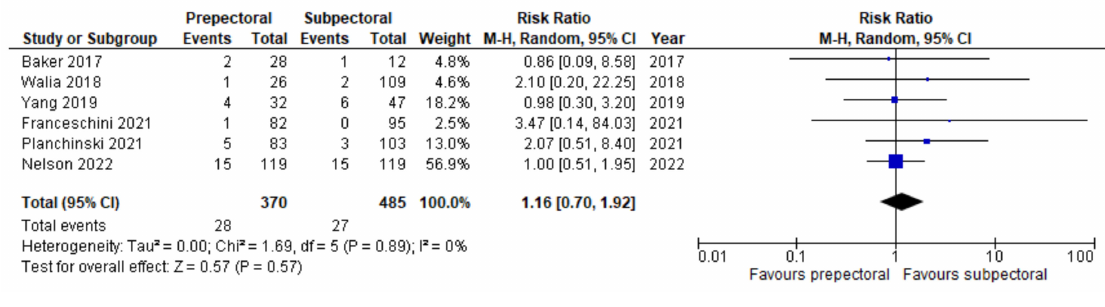
Figure 5. Skin necrosis [14,16,17,19,21,22].